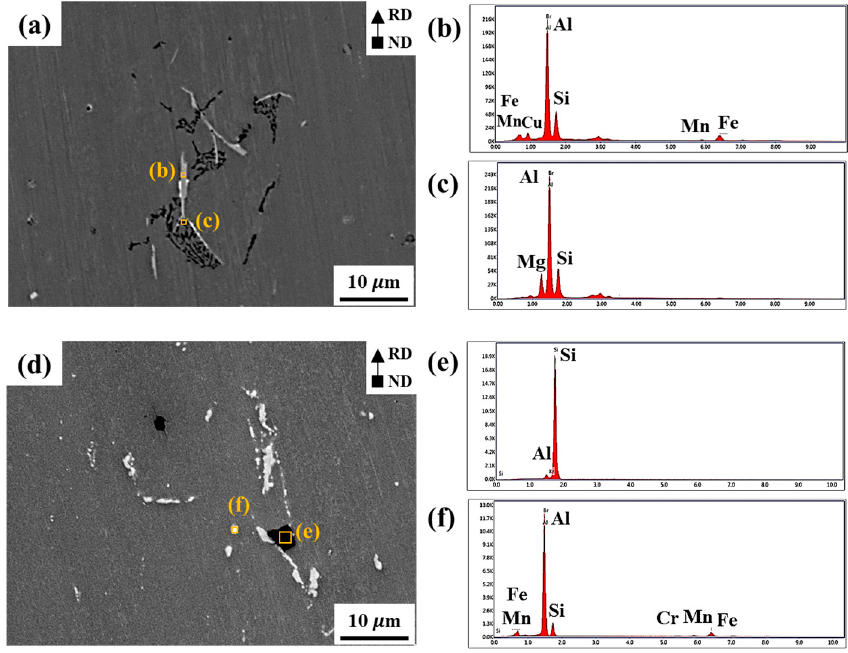
Figure 2. SEM images of ( a ) RH and ( d ) RL sheets, and ( b , c , e , f ) EDS spectrum of marked area marked in ( a , d ).